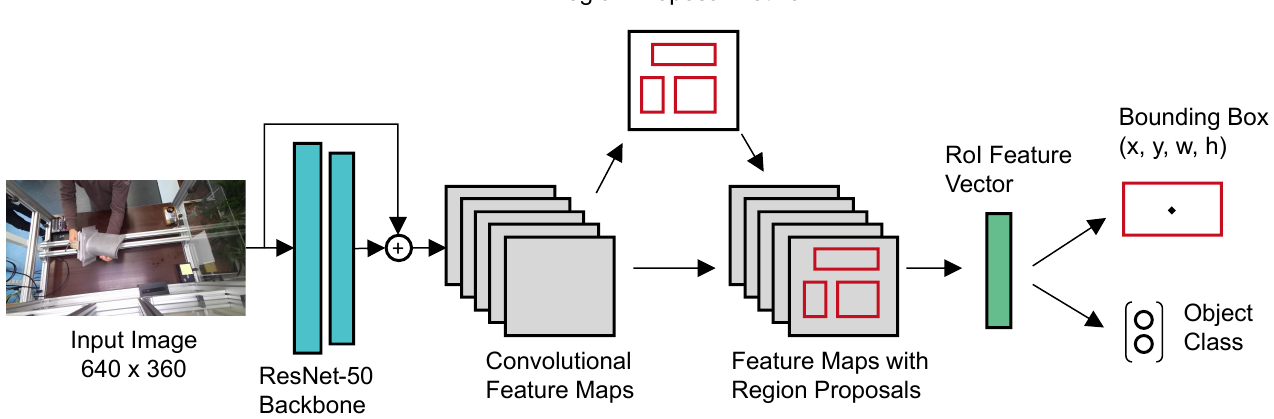
Figure 10. Object detection model based on Faster